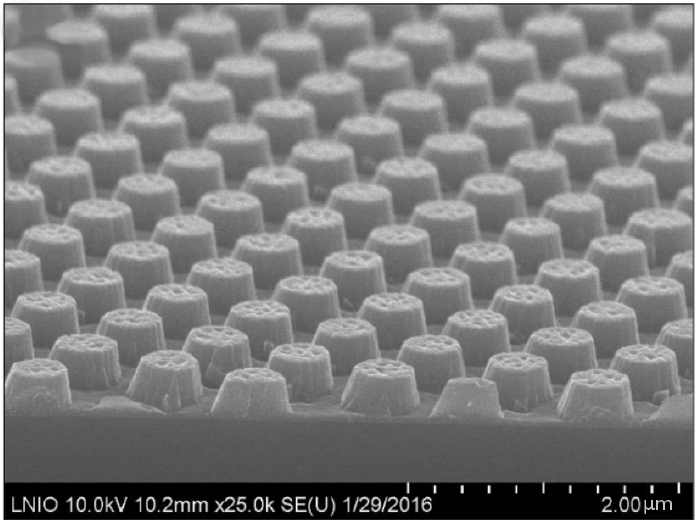
Figure 15. SEM picture of the TiO 2 PhC pattern [47].